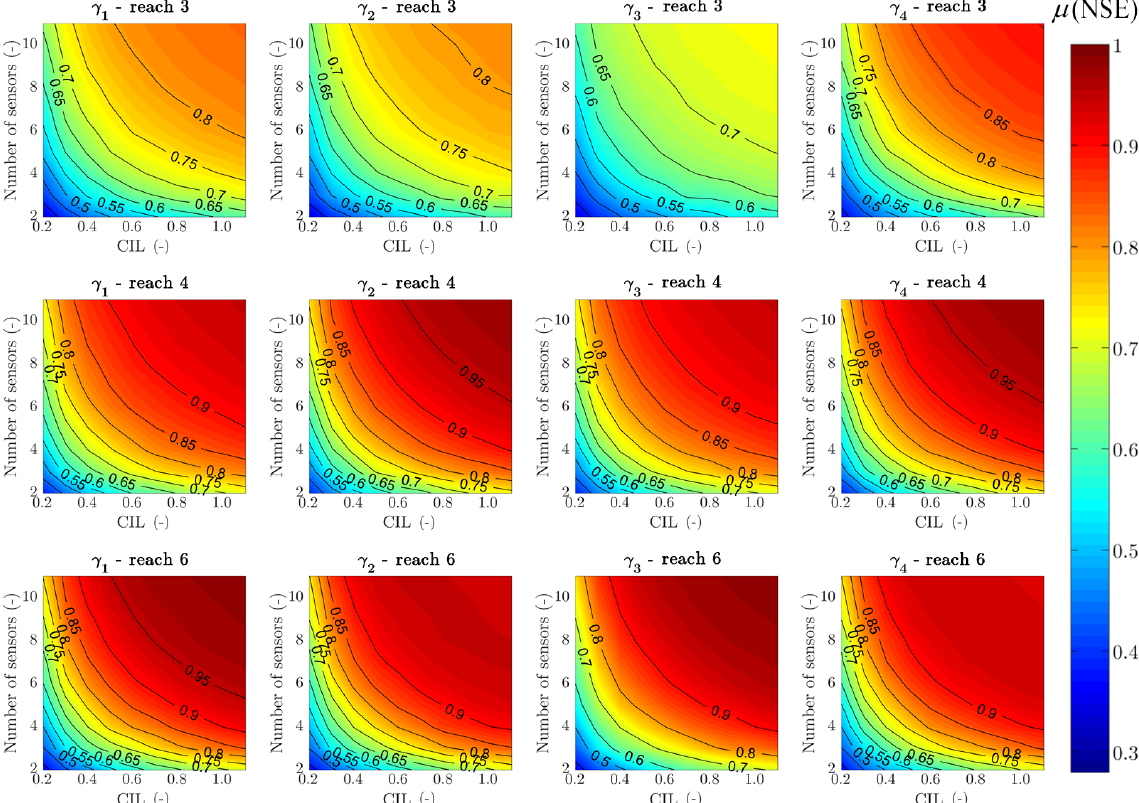
Figure 7. The µ ( NSE ) values obtained considering random location of dynamic social (DySc) sensors along river reaches 3, 4 and 6 in four different cases of CS observation bias for 1h lead time and citizen involvement level (CIL)